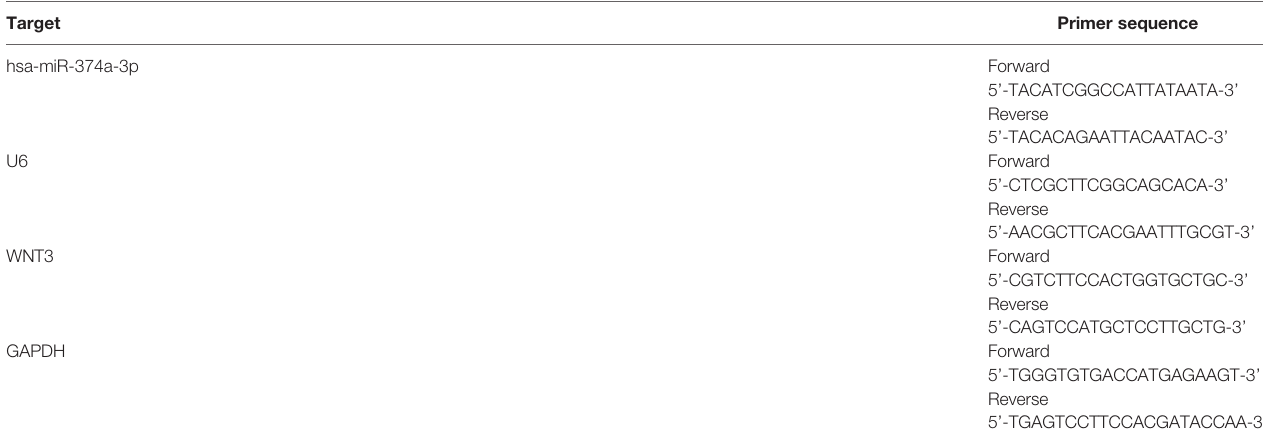
TABLE 1 | Primers used for